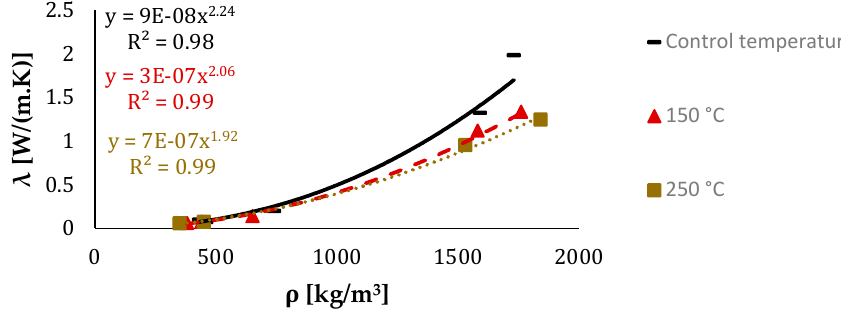
Figure 13. Relationship between bulk density and thermal conductivity coefficient.